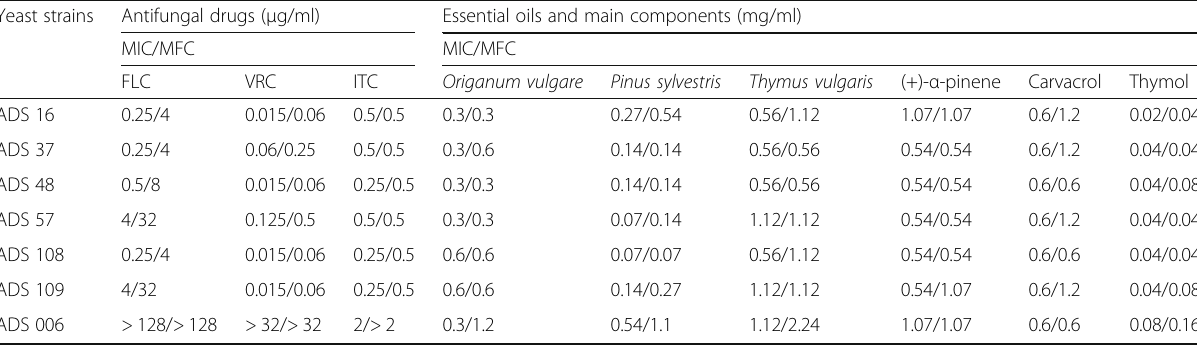
Table 2 In vitro antifungal activity of azoles and essential oils against Cryptococcus neoformans azole-susceptible and not-susceptible clinical